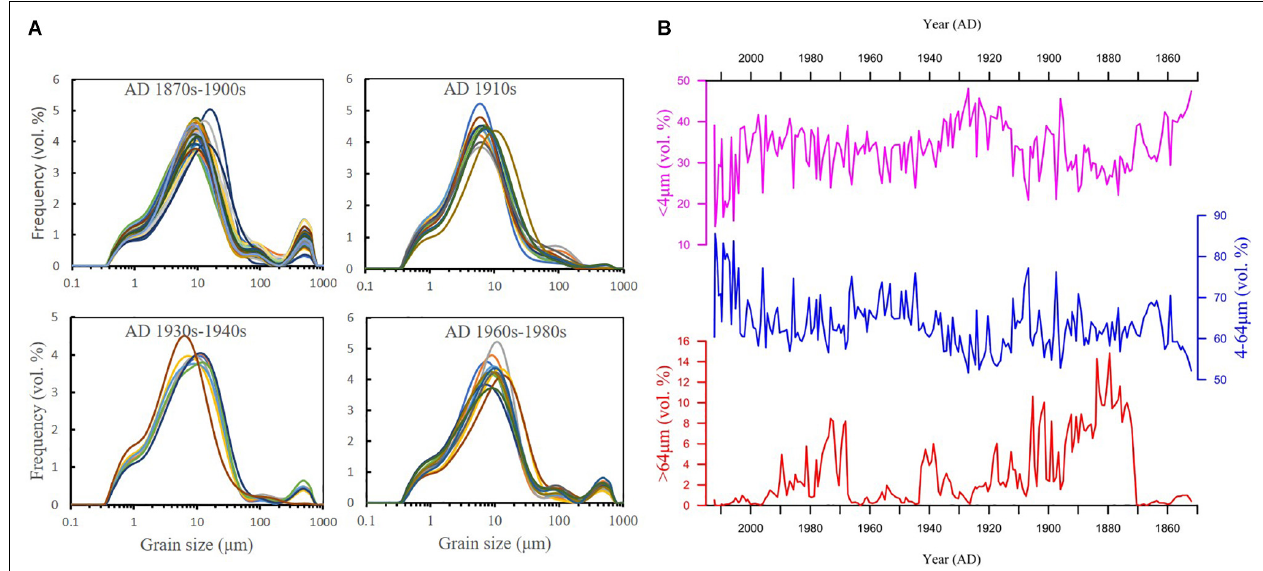
FIGURE 2 | (A) Grain-size frequency distribution patterns of sediments of core KLKL13-2 during the intervals of AD 1870s–1900s, AD1910s, AD 1930s–1940s, and AD 1960s–1980s (the relevant dust storm events are shown in Figure 4 ); (B) Proportions of three major fractions: clay ( < 4 µ m, pink), silt (4–64 µ m, blue), sand ( > 64 µ m, red) fraction in core